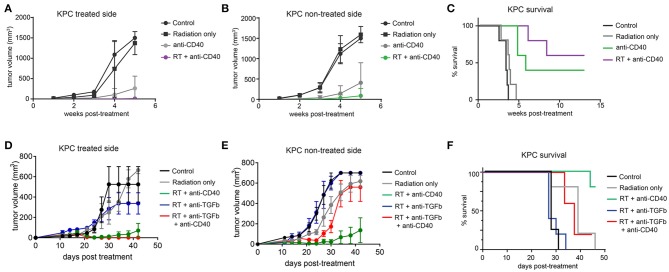
Combination 10Gy RT and anti-CD40 induces regression of contralateral KPC tumors, but TGFβ blockade counteracts the abscopal effect of anti-CD40. C57BL/6 mice were inoculated on each flank with 150,000 KPC cells. Once tumors reached palpable size (11–14 days post-implantation), mice were treated with 10Gy SBRT, anti-CD40 (20 μg once, intratumoral), both RT and anti-CD40, or PBS control. (A) Volume of treated side tumors over time. (B) Volume of contralateral tumors over time. (C) Overall survival. (D–F) C57BL/6 mice were treated as in (A–C), except anti-TGFβ (200μg intraperitoneal every 3 days starting at the time of SBRT) was included where indicated. n = 5/group. Error bars are SEM.